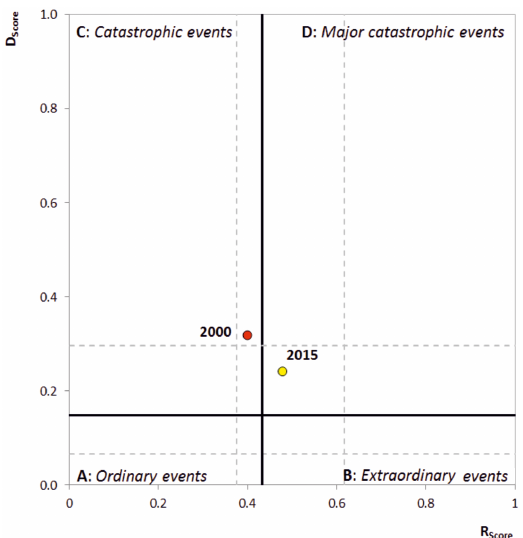
Figure 8. Chart classifying the analysed events according to their magnitude. D score and R score are described in Sect.